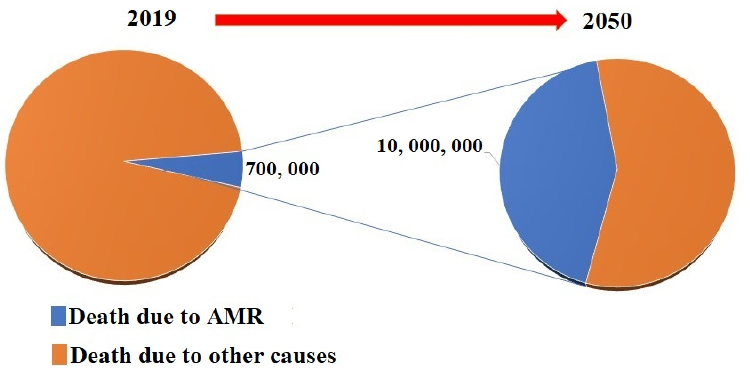
Figure 1. Pie chart showing current number of antimicrobial-resistant mediated global deaths and expected number of global deaths due to antimicrobial-resistant infectious diseases in 2050.